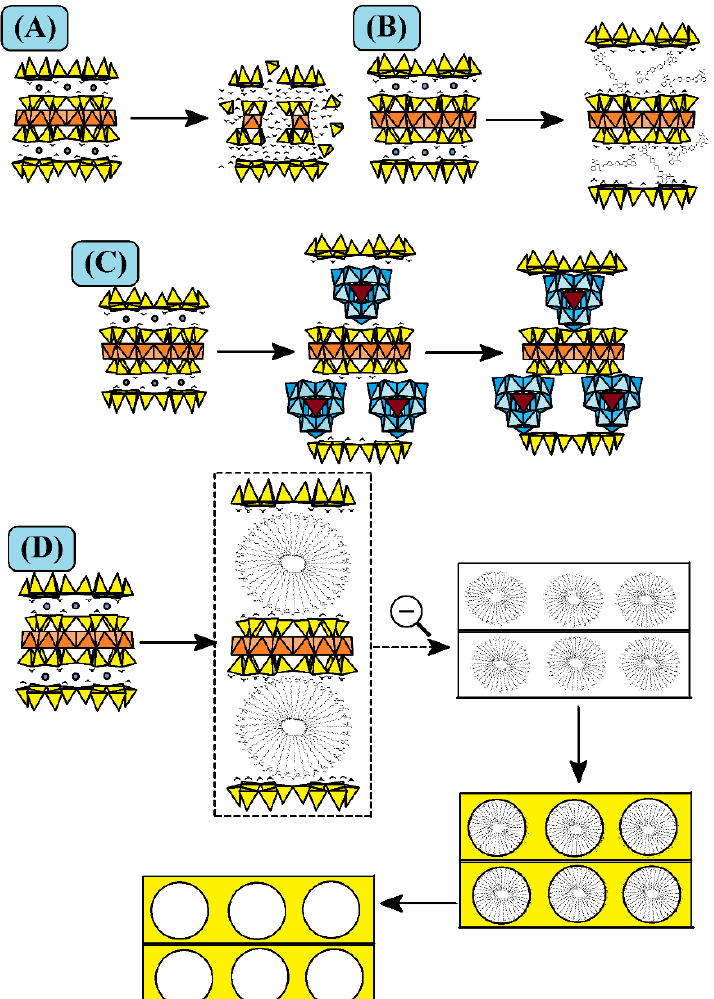
Figure 4. Modification of smectites through several treatments: ( A ) Acid treatment; ( B ) intercalation of organic compounds to form organoclays; ( C ) pillared clays (PILCs) and ( D ) porous clay heterostructures (PCHs).